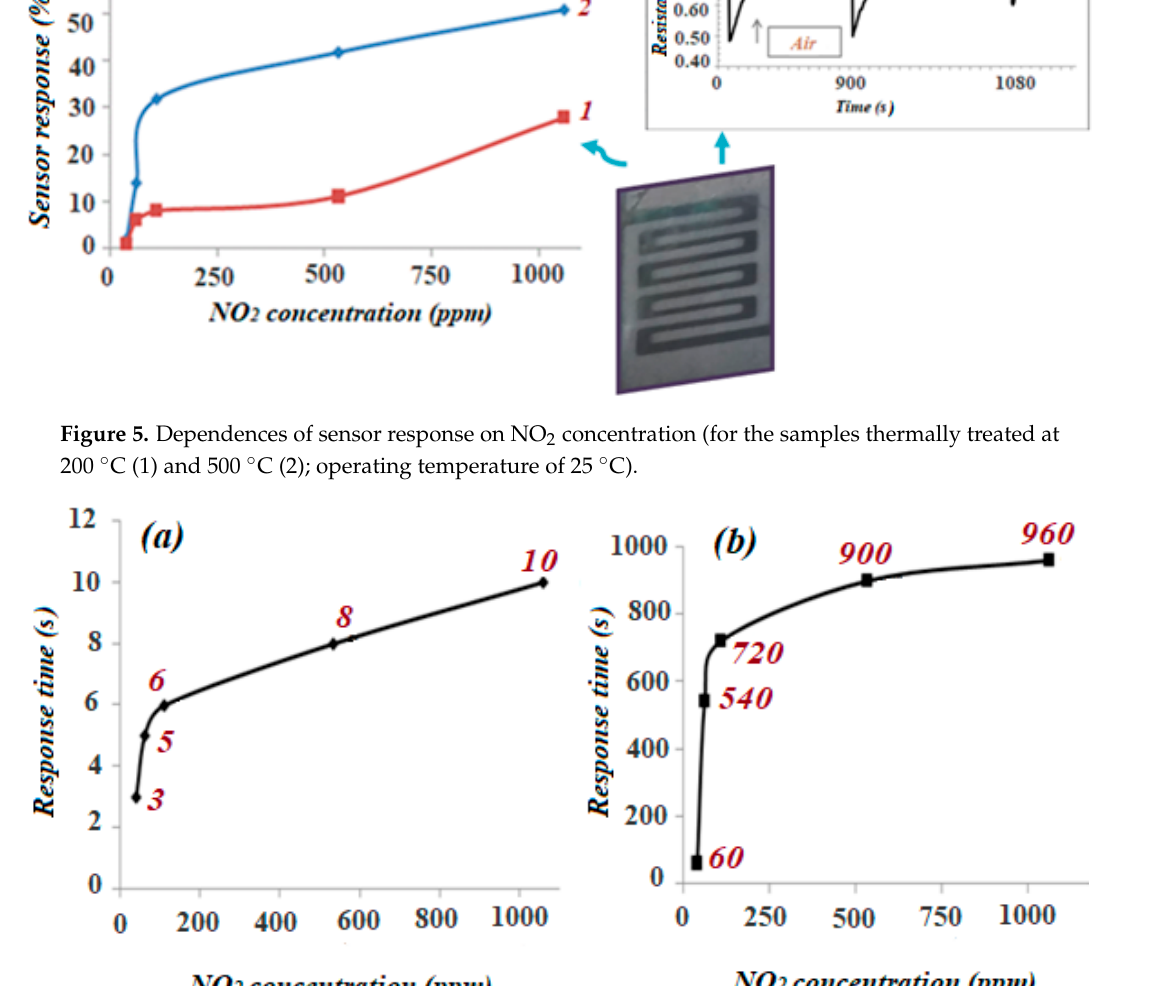
Figure 6. Dependences of response ( a ) and recovery ( b ) time on the concentration of NO 2 .